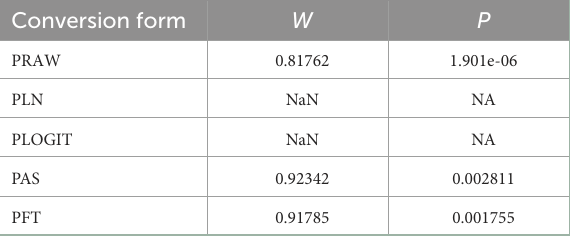
TABLE 5 Normal distribution test for the normal rate and the different conversion of the normal rate. Conversion form